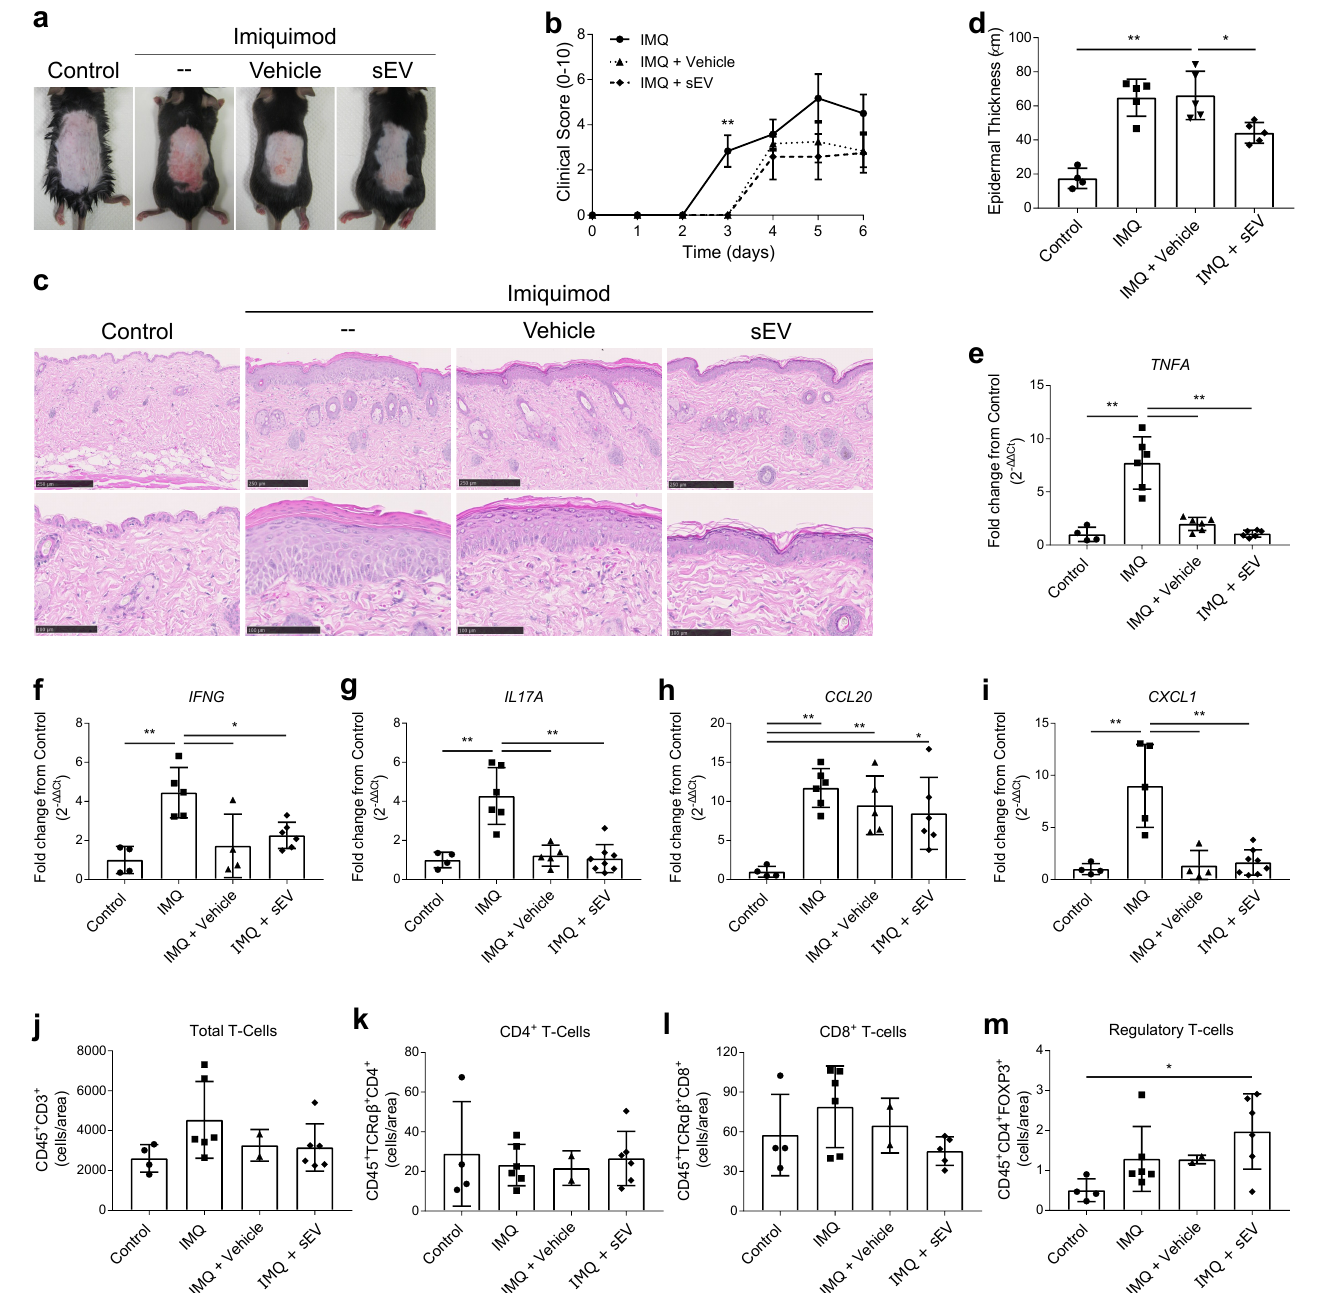
Figure 4. Therapeutic potential of UCB-MNC-sEV for imiquimod-induced psoriasis. C57BL/6 mice received 5% imiquimod (IMQ) on their shaved backs (approx. 7 cm 2 ), daily for 6 days. A topical formulation containing 2 × 10 10 particles/mL UCB-MNC-sEV was applied to the same area every day, 1 h after IMQ. ( a ) Representative photos and ( b ) clinical score ( n = 6). ( c ) Representative H&E microphotographs used to measure ( d ) epidermal thickness ( n ≥ 4). Scale bars = 250 µ m or 100 µ m, respectively, for upper and lower microphotographs. Epidermal thickness was measured from stratum basale to stratum granulosum , averaging 5 measurements per section, for a total of 20 data points per animal. ( e – i ) Relative expression of pro-inflammatory mediators in the skin of all tested groups ( n 4). ( j – m ) Digested skin of all four test groups was analyzed by flow cytometry for identification of total, CD4+, CD8+ and regulatory T-cells ( n ≥ 2). All results are presented as mean ± SD. * p ≤ 0.05, ** p ≤